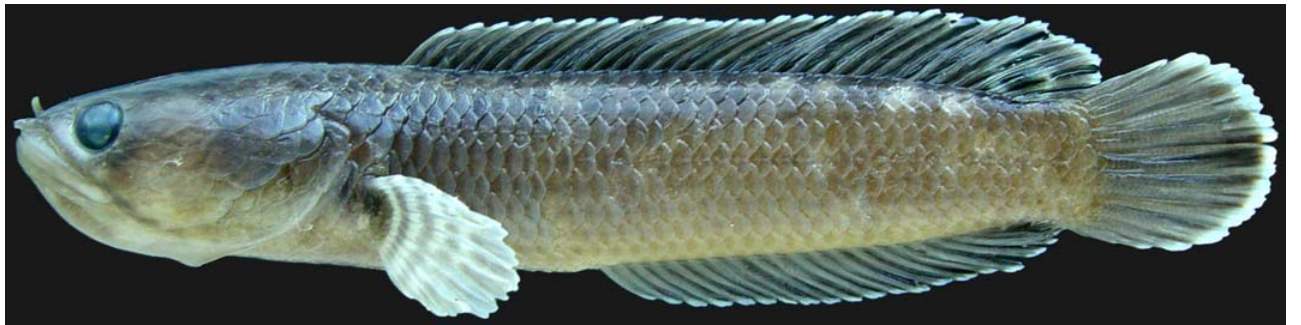
Image 6. Side view of Channa gachua (MUMF uncat., juvenile)